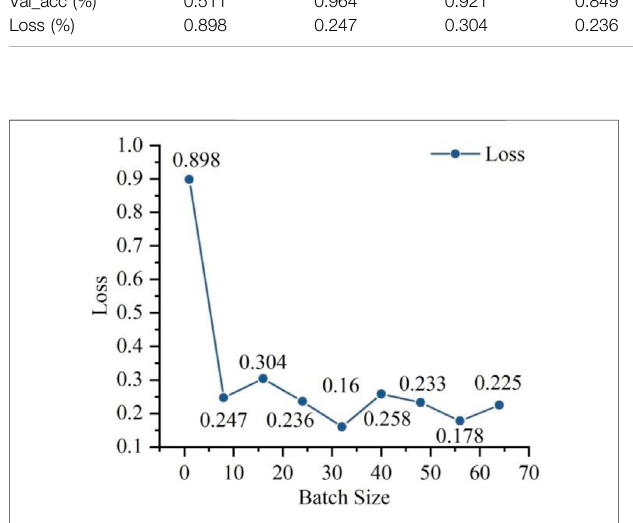
FIGURE7| Thelossfunctionoptimizationprocesswith fi